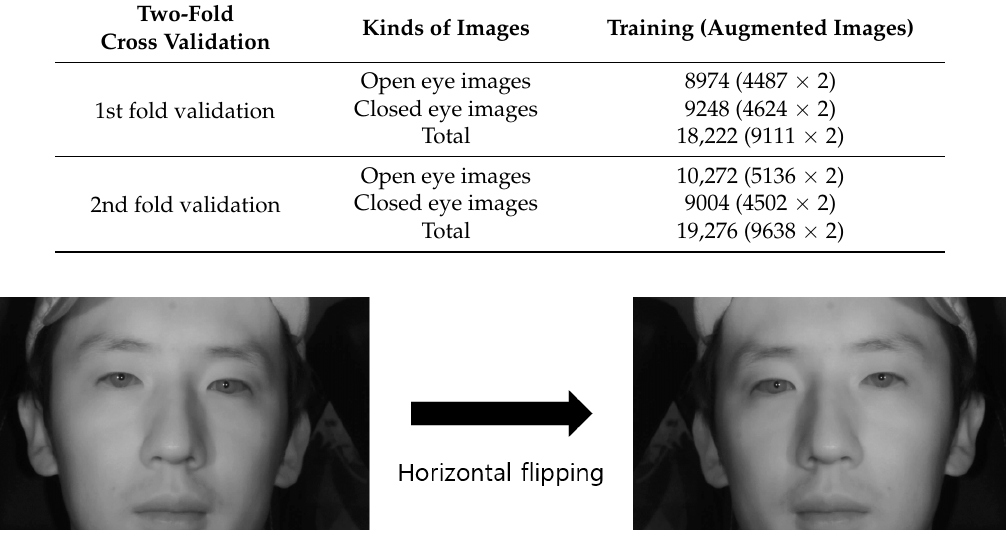
Figure 16. Data augmentation through horizontal flipping. Table 7. Image database for the evaluation of faster R-CNN.